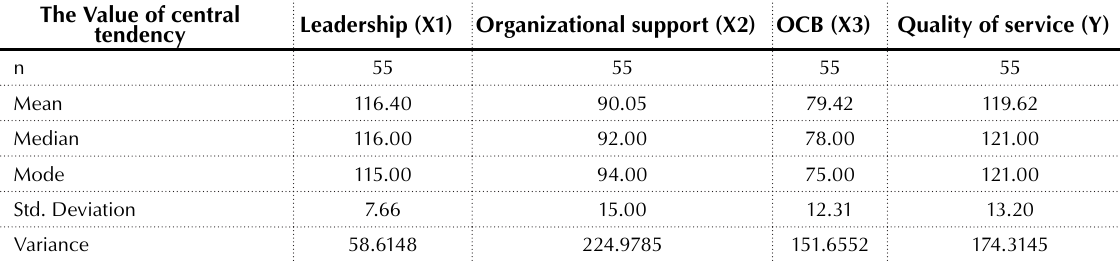
Table 1. Summary of statistics data of the research The Value of central